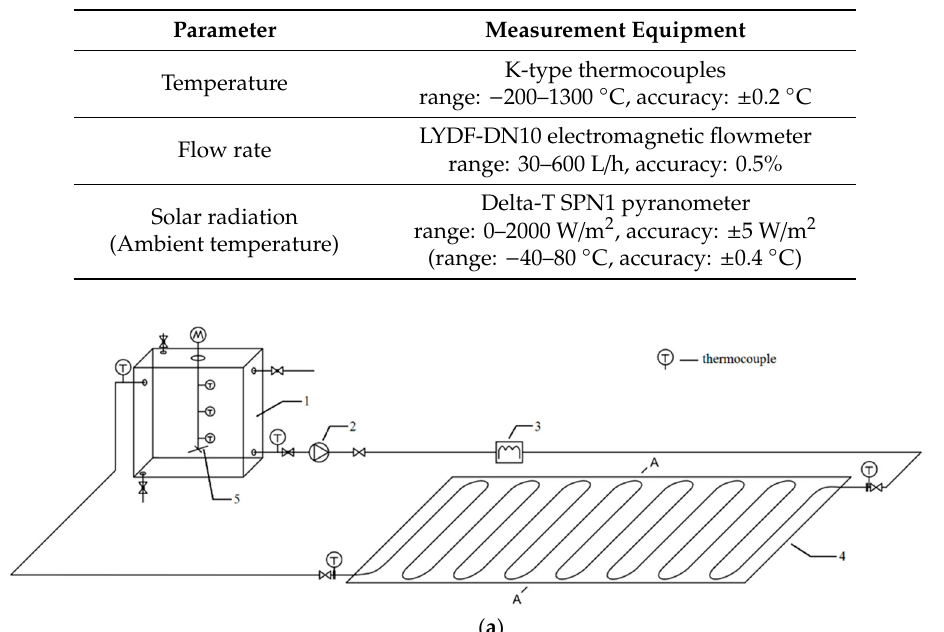
Table 2. Measuring range and accuracy.